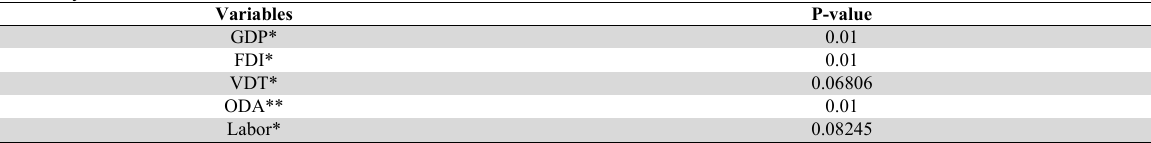
Stationary test of variables